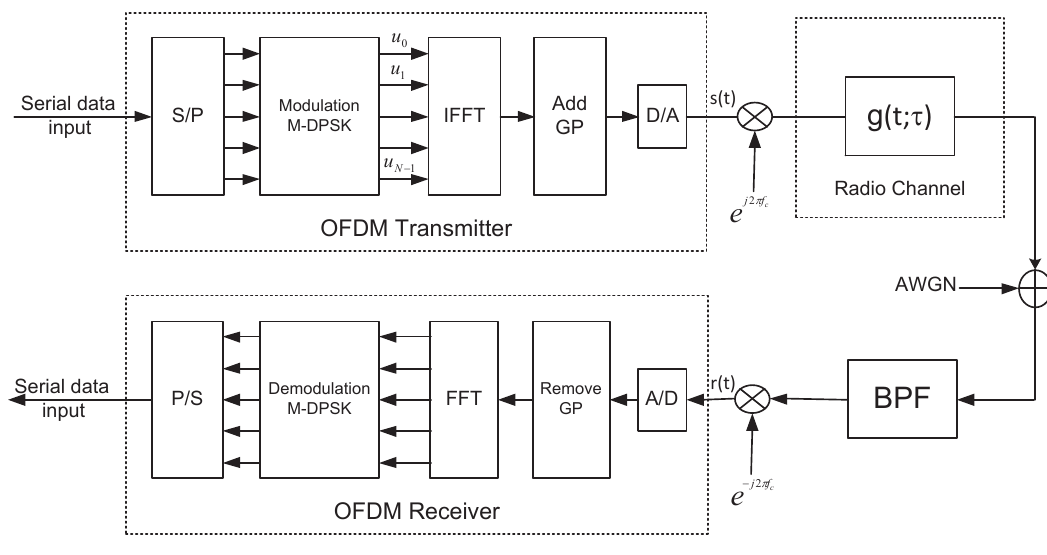
Figure 1. Block diagram of the transmitter and receiver for the differential-phase OFDM